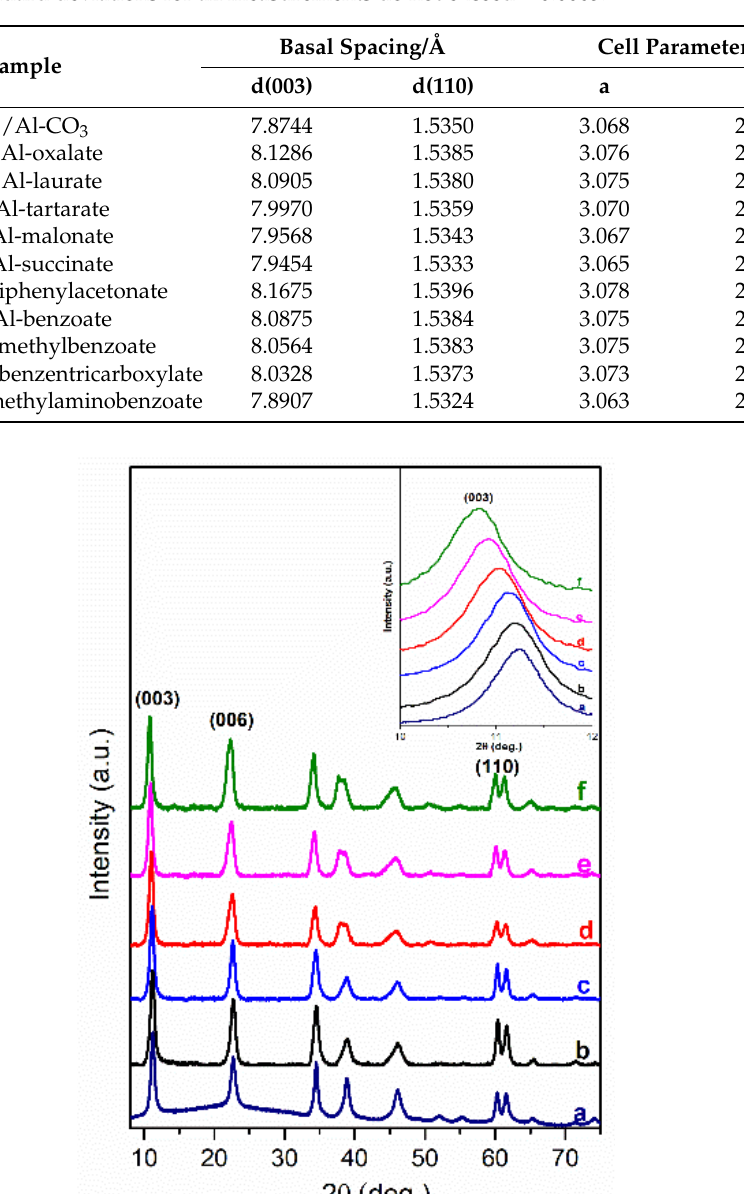
Table 1. The determined values of d spacing and lattice parameters of anion-intercalated Mg 3 /Al LDHs. The standard deviations for all measurements do not exceed ± 0.0005.